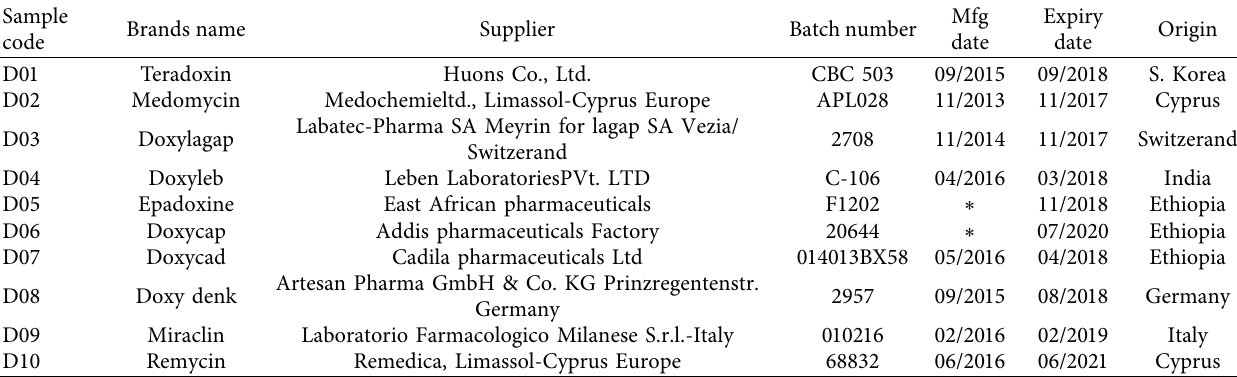
Table 1: Profile of doxycycline hyclate 100mg capsule and tablet brands marketed in Jimma,